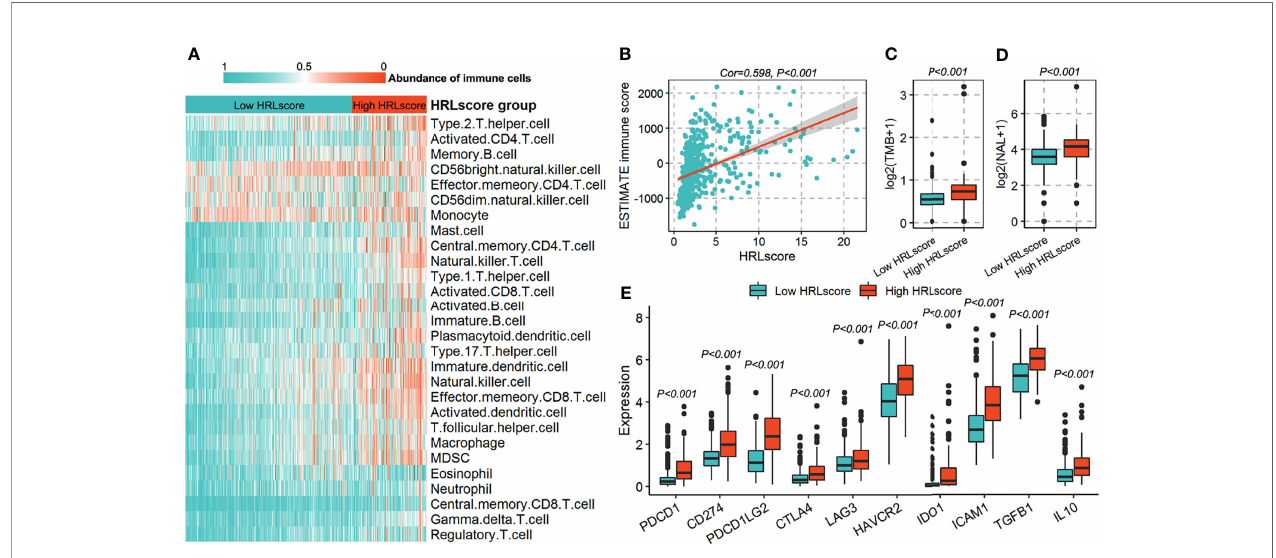
FIGURE 5 | Immune characteristics for patients in the TCGA-LGG cohort. (A) In fi ltration of 28 immune cell types between high- and low-HRLscore groups. (B) Correlation of HRLscore and ESTIMATE immune score. (C) Tumor mutation burdens (TMBs) between patients with high and low HRLscore. (D) Neoantigen loads (NALs) between patients with high and low HRLscore. (E) Expression of immune checkpoints and immunosuppressive cytokines between different HRLscore